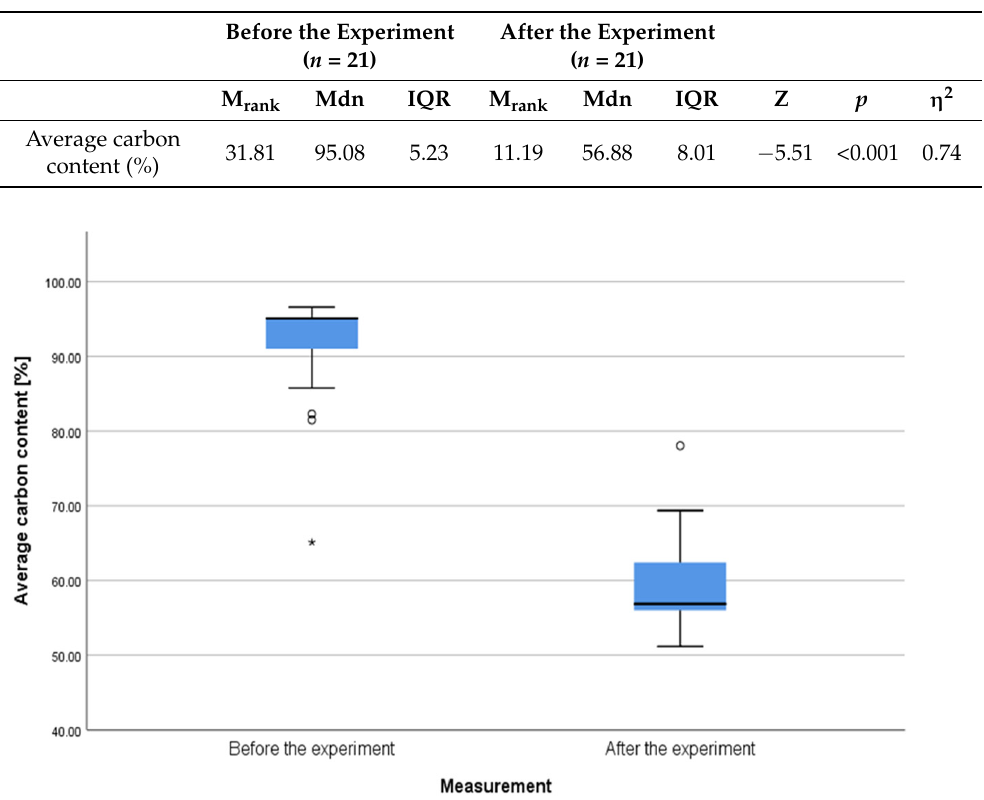
Table 3. The results of the Mann–Whitney U test checking the differences between the measurement before and after the cultivation in the mean carbon content (%).